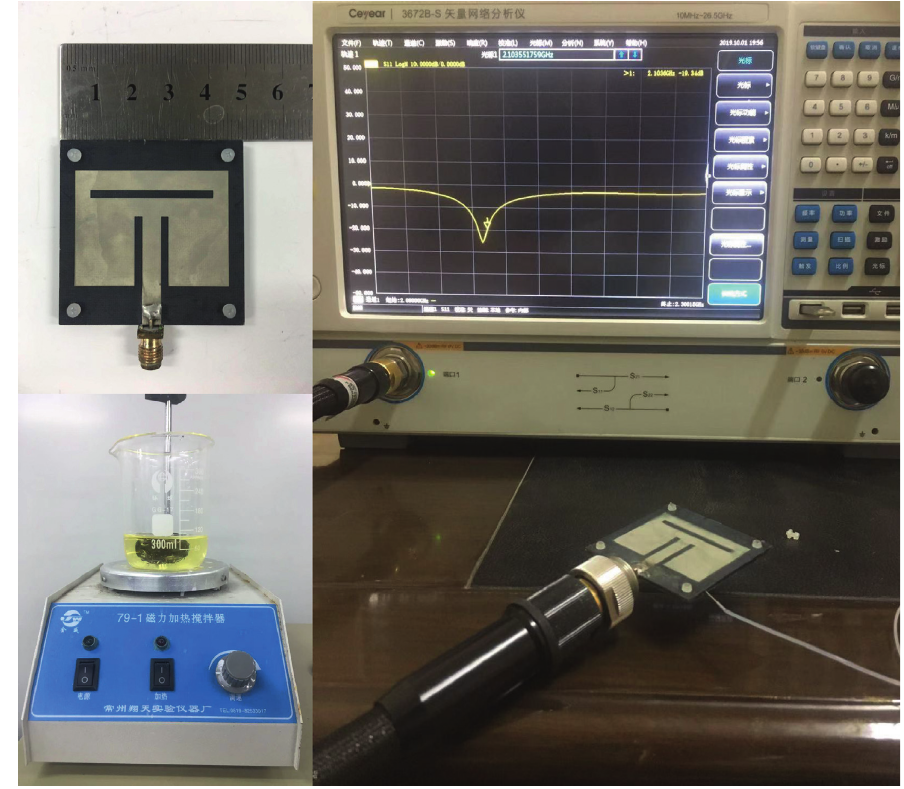
Figure 9: Fabricated microfluidic sensor and experiment